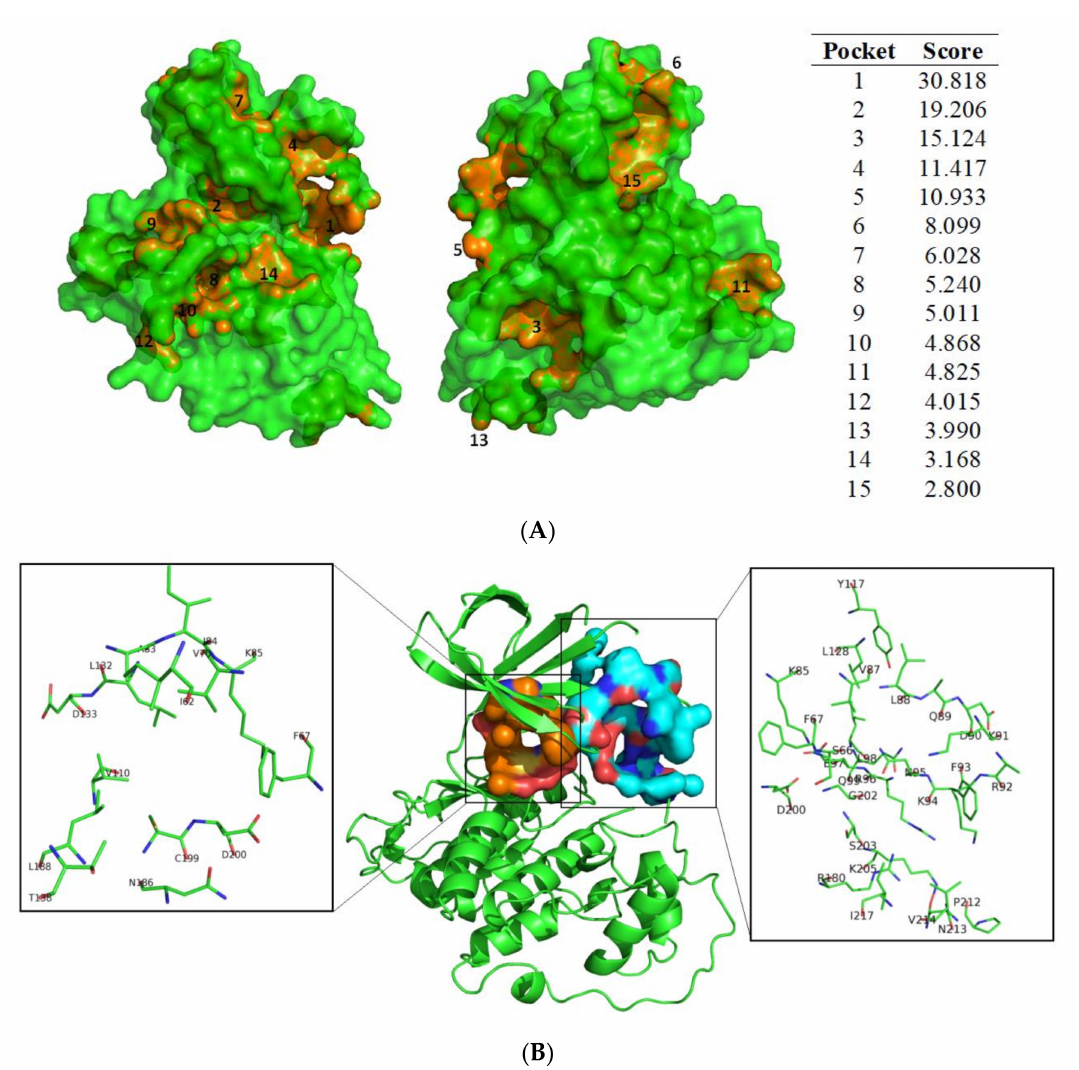
Figure 3. ( A ) Cavities found by fpocket and plot on surface. Numbers correspond to the ranking given by fpocket (1 is the best, and 15 the worst). In the list the score values of each pocket are shown. No worse details regarding the scoring function of fpocket can be found at Le Guilloux et al. (2009) [50]. ( B ) Pockets location and amino acids involved in each cavity. In the central image, a cartoon representation of the structure of GSK3 β (PDB 6B8J) is depicted. In orange, the surface and the ATP-cavity are shown, while the blue surface represents the substrate binding pocket. In the left zoom image, all the amino acid residues that construct the ATP pocket are shown in sticks. In the right zoom image those residues that compose the substrate pocket are shown. Letters and numbers correspond to their position in the amino acid sequence and the 6B8J PDB file